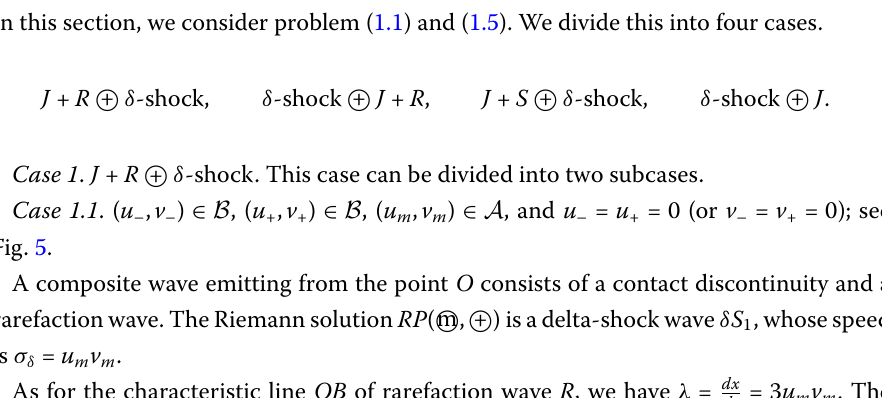
Figure 5 Case 1.1. J + R + (cid:10) δ